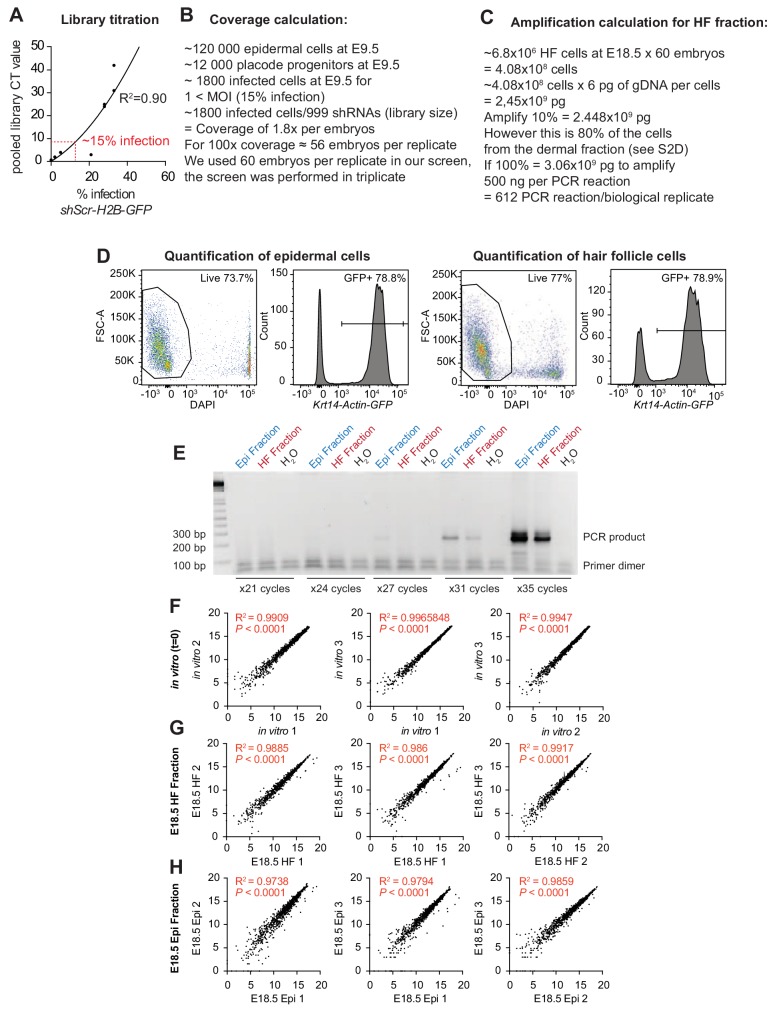
Establishment of conditions for the screen.Screen set up, parameters and correlation between biological replicates. (A) Titration of the lentiviral library so that only ~15% of the E9.5 skin progenitors were infected, thereby ensuring a multiplicity of infection <1. (B) Screen coverage calculation. ~56 embryos are required per biological replicates to ensure that at least 100 E9.5 skin progenitors that will become HF progenitors are transduced with the same shRNA (100x coverage). (C) Calculations to ensure adequate amplification of genomic DNAs at E18.5. Shown are calculations for the HF fraction. Refer to Beronja et al. (2013) for details on the epidermal fraction. (D) Flow cytometry analysis of dispase separated epidermal and HF fractions from Krt14-Actin-GFP mice. The separated dermal fraction contains a high proportion (80%) of HF cells at E18.5 (GFP+), which is used in our amplification calculation. Representation of n = 3 embryos. (E) The sequencing library was prepared using custom primers containing adapter and sequencing features for the Illumina flow cells as well as a four nucleotide barcode for multiplex sequencing to amplify the shRNAs present in each population (Beronja et al., 2013). Shown is a representative example showing that the PCR reaction produces a clean PCR product after 31 cycles of amplification. (F–H) Correlation between biological replicates. Spearman correlation, R2 and P values for each comparison are indicated on the corresponding graphs.